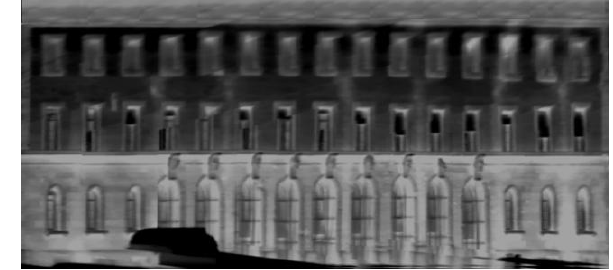
Figure 7. Surface texture generated from the complete image sequence